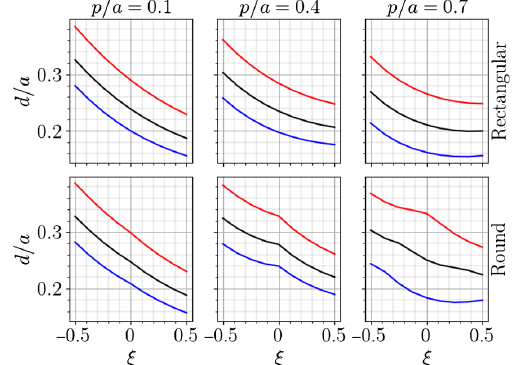
FIG. 5. Corrugation depths calculated for minimum radii corrugations (top) and maximum radii corrugations (bottom) for aperture ratios of a= λ ¼ 0 . 53 (red), a= λ ¼ 0 . 60 (black), and a= λ ¼ 0 . 67 (blue). See Fig. 4 for cell geometries.